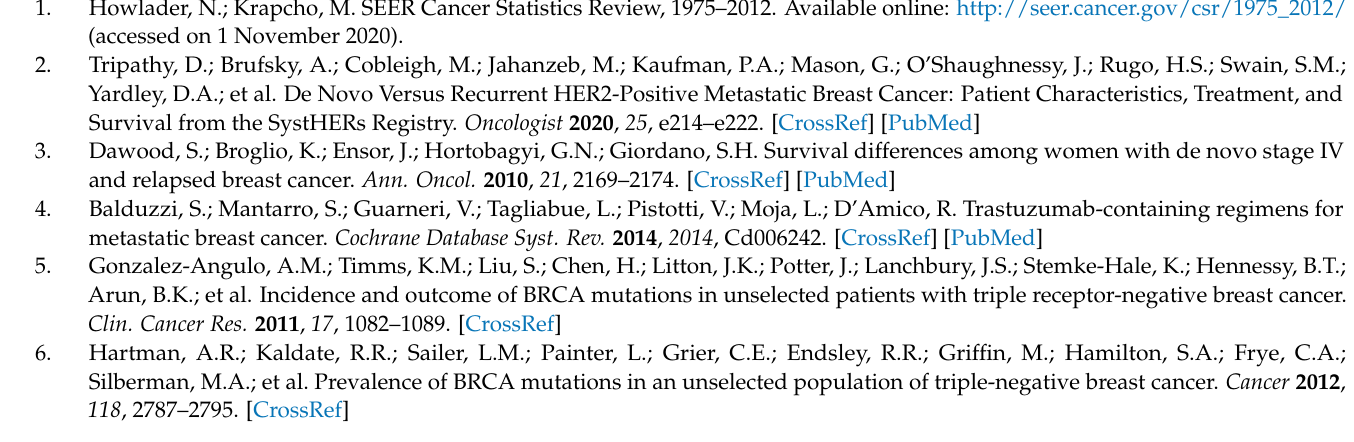
Figure S2. Kaplan-Meier curve of overall survival stratified by IBC (A), ER (B), PR (C), HER2